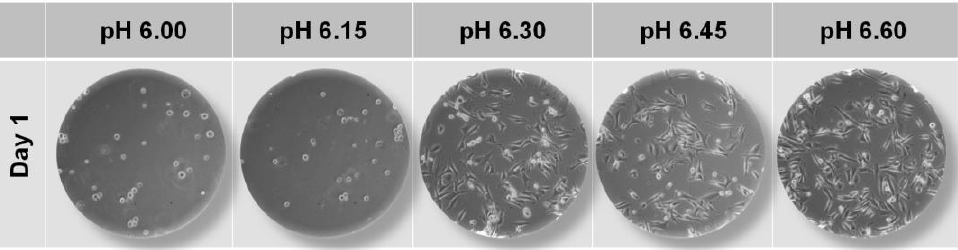
Figure 2. The effect of external pH on the growth of MDA-MB-231 cells, a metastatic human breast cancer cell line. MDA-MB-231 cells were seeded in a 12-well plate and they were incubated at five different pHs of DMEM: pH 6.0, pH 6.7, pH 7.4, pH 8.4, and pH 9.2. ( a ) Cells were imaged by a light microscope on day 1 and day 5. ( b ) The number of cells was also counted everyday by a hemocy- tometer.